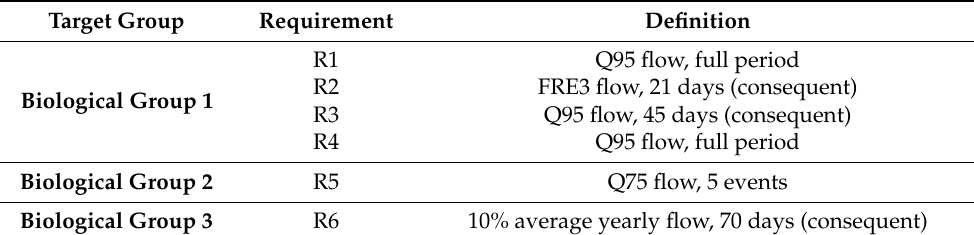
Table 1. E-flow requirements considered in this study: The requirements define the hydrological conditions to be conserved in the river during the daily diversion operations throughout the year. Q95–Q75 is the flow value that is exceeded 95% and 75% of the time, respectively; FRE3 is the flow value that exceeds three times the median